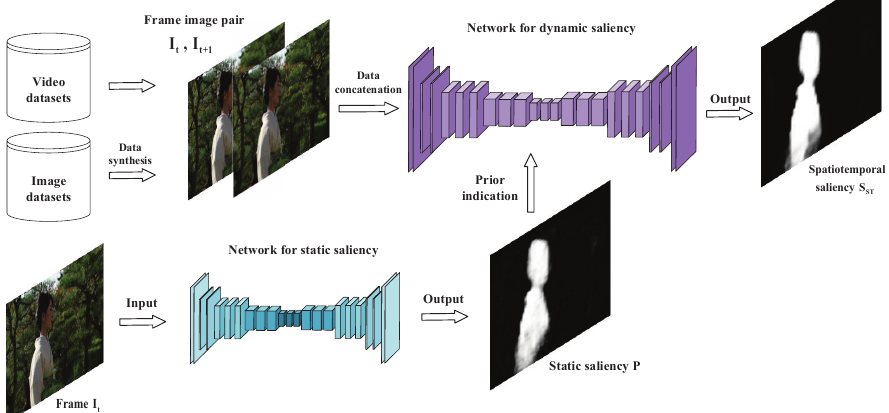
Figure 4. Illustration of our network for dynamic saliency